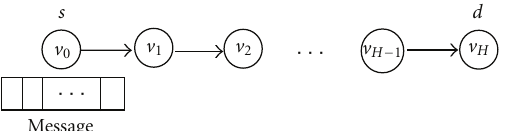
Figure 2: Unicast path example: node s sends a message to node d over path Q = (cid:3) s = v 0 , v 1 , v 2 , ... , v H − 1 , v H = d (cid:4) .